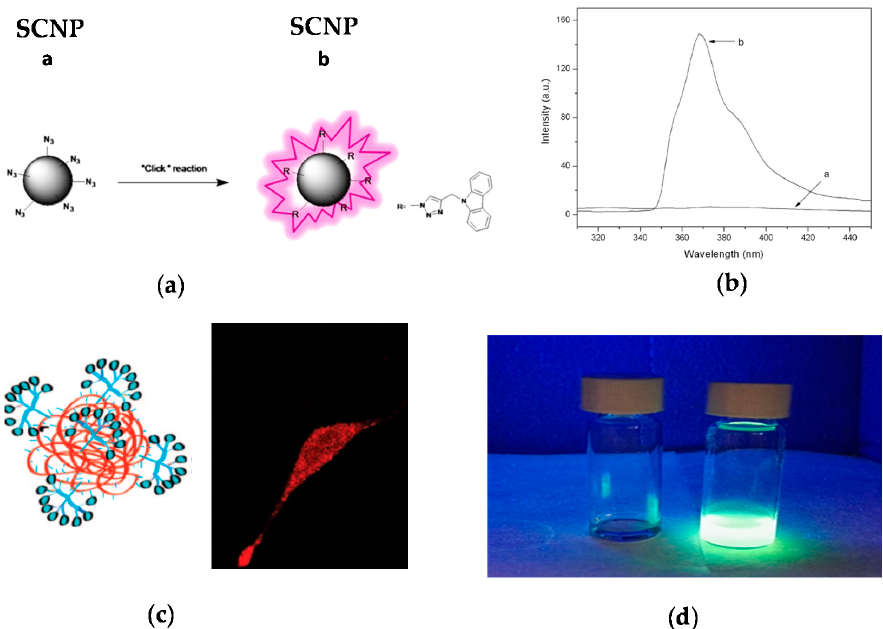
Figure 7. Schematic illustration of the post-functionalization of a SCNP with a fluorophore molecule ( a ), photophysical characterization of the resulting fluorescent SCNP ( b ), and two examples of fluorescent SCNPs decorated with: ( c ) Alexa Fluor 568 dye, and internalized by a fibroblast cell as recorded by confocal fluorescent microscopy, and ( d ) dansylhydrazine (reprinted with permission from [45], Copyright Elsevier, 2014; [46], Copyright American Chemical Society, 2009; and [47], Copyright Royal Society of Chemistry, 2016, respectively).